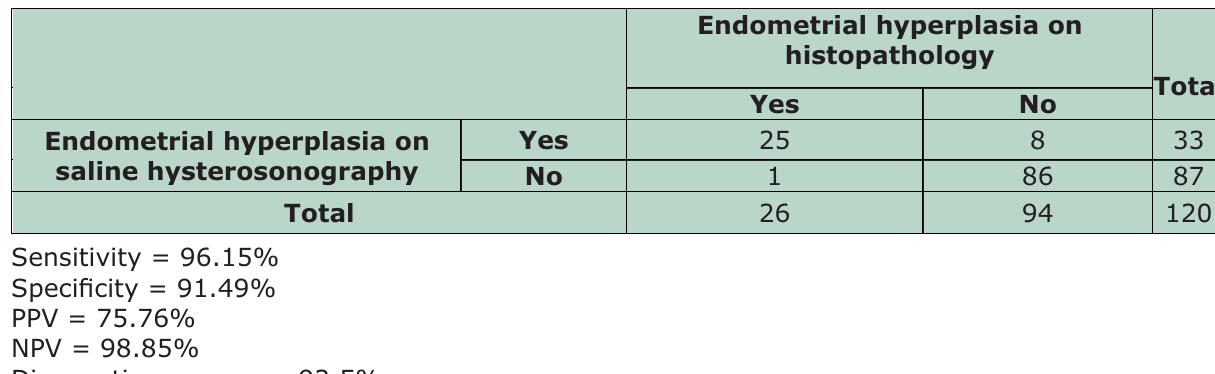
Table-III: Diagnostic accuracy of Saline Hysterosonography